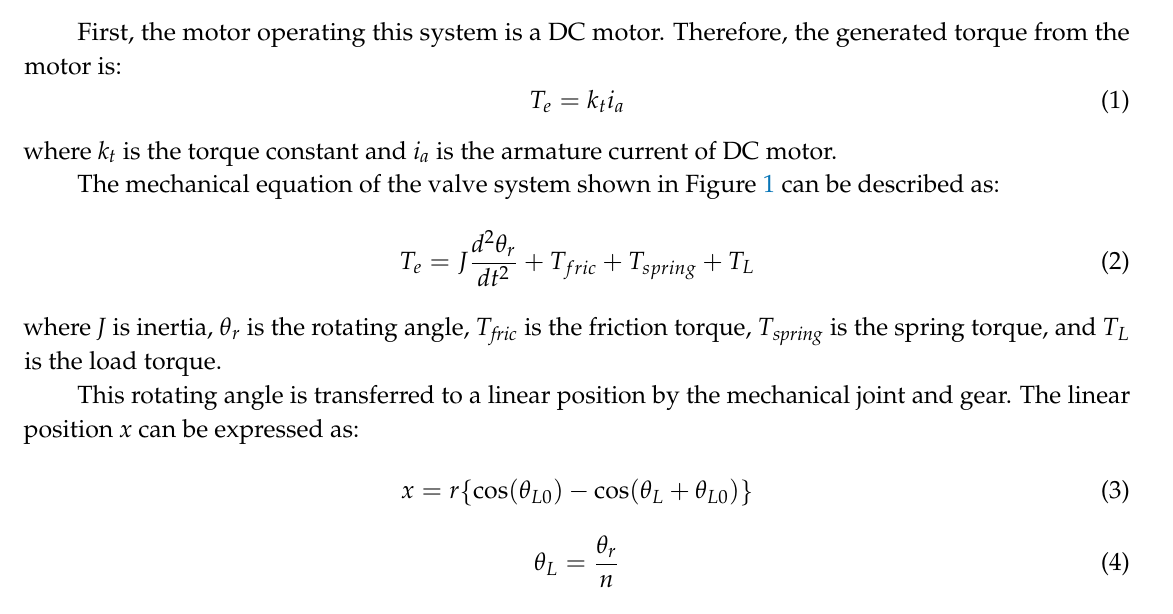
Figure 1. Mechanical composition of exhaust gas recirculation (EGR) valve.